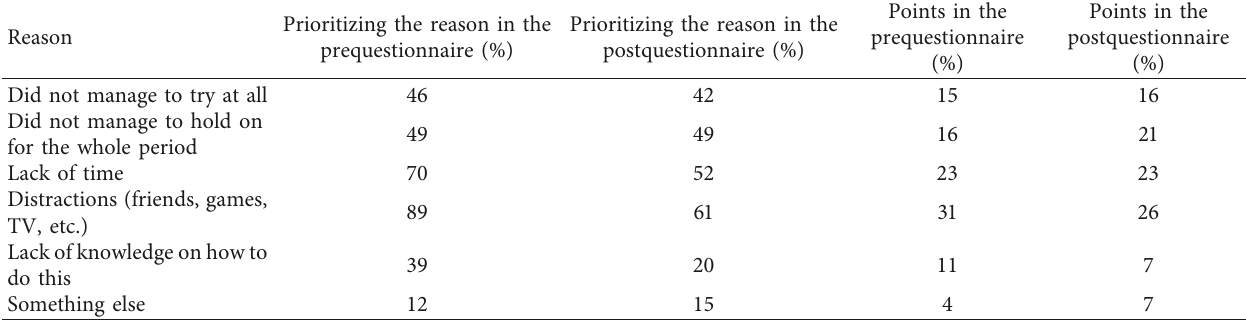
Table 6: Results from the question “Which were the top 3 reasons that your study technique was not as good as you planned ? ” in the postquestionnaire and the similar question in the prequestionnaire. To summarize the results in a single number, we give the top-ranked reason 3 points, the second 2 points, and the third 1 point. Some students (17%) did not state any reason at all, 2% stated only one reason, 6% stated two reasons, and 75% stated three reasons.